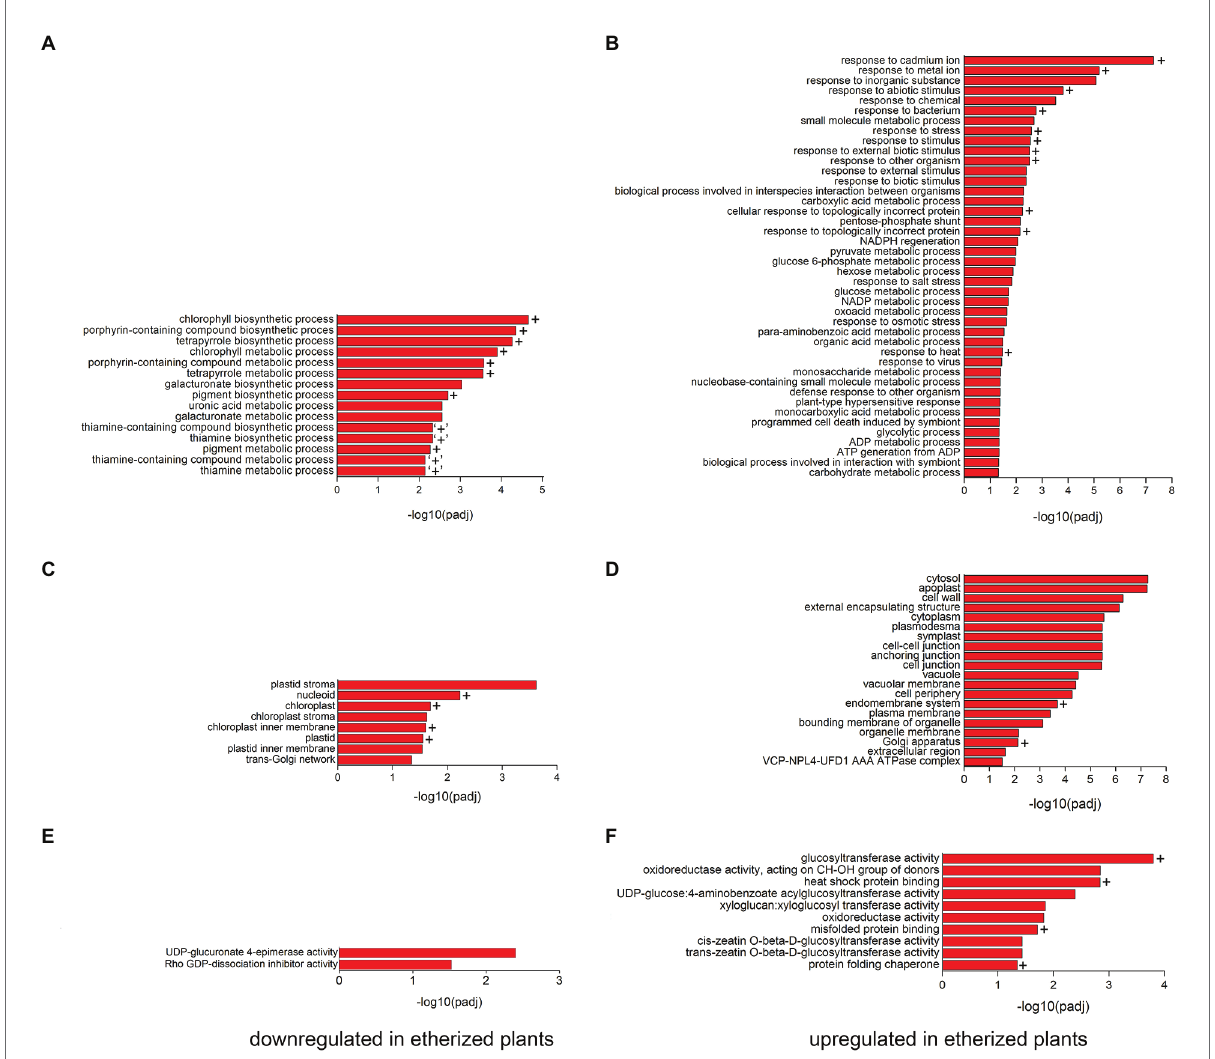
FIGURE 3 Gene ontology (GO) functional analysis of differentially expressed proteins (DEPs) in Arabidopsis thaliana . All the significantly ( p < 0.05) enriched downregulated GO terms in biological process (A) , cellular component (C) , and molecular function (E) branches in etherized plants compared to control are presented. All the significantly ( p < 0.05) enriched upregulated GO terms in biological process (B) , cellular component (D) , and molecular function (F) branches in etherized plants compared to control are presented. All the adjusted statistically significant values of the terms were negative 10-base log transformed. Crosses (+) denote the same or very similar GO terms, which were enriched also in RNA-seq experiments. “+” denote similar GO term from RNA-seq experiments (vitamin metabolic and vitamin biosynthetic processes) which contain downregulated genes for thiamine biosynthesis. A complete list of DEP is available as Supplementary Table